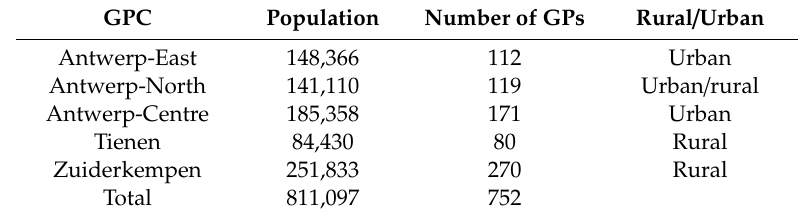
Table 1. Characteristics of the five general practitioner cooperatives (GPCs) providing data for this